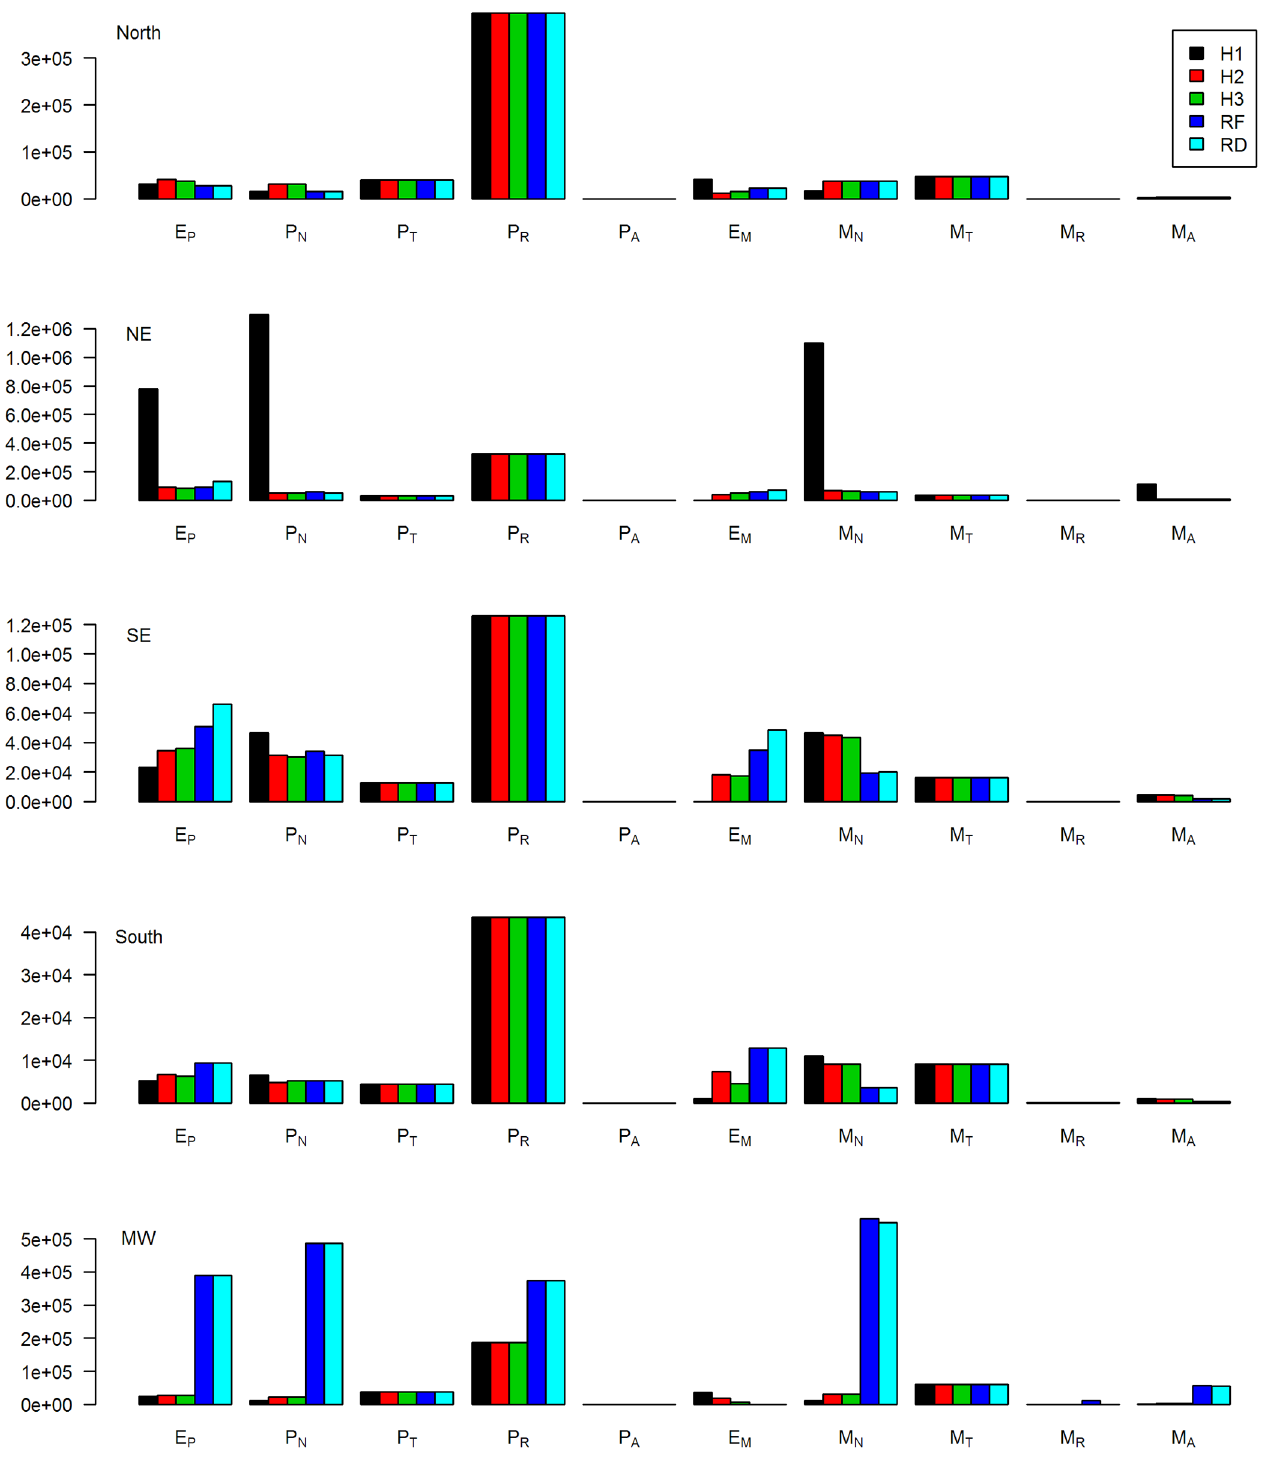
Fig 2. Number of initial population in infected categories for a dynamic model of Mycobacterium leprae in Brazilian regions. The colors represent different model fits (black H1: fitted transmission parameters shared across all regions, red H2: fitted transition parameters shared across all regions, green H3: all fitted parameters shared across all regions, dark blue RF: no fitted parameters shared across regions, and light blue RD: no fitted parameters shared across regions and density-dependent transmission). Each row is a different region. The infected categories are: E P , latent paucibacillary (PB); P N , undetected PB; P T , treated PB; P R , recovered PB; P A , recurrent PB; E M , latent multibacillary (MB); M N , undetected MB; M T , treated MB; M R , recovered MB; and M A , recurrent